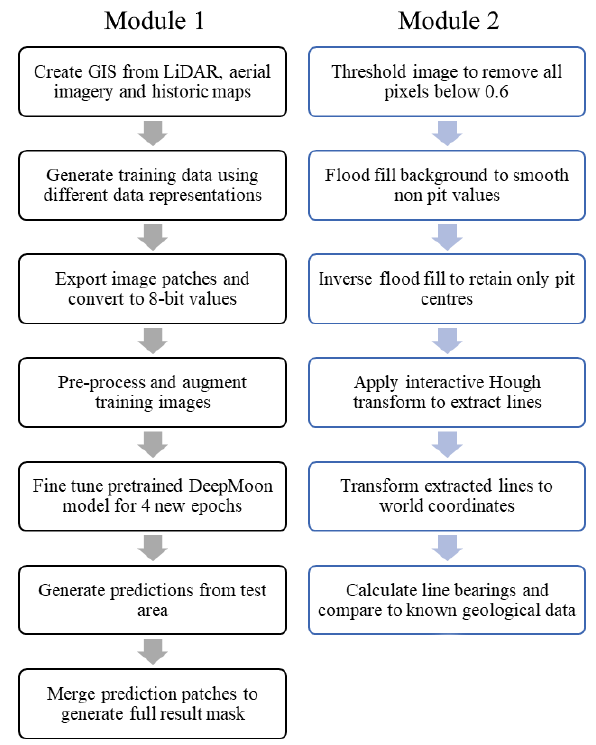
Figure 3. Processing workflow diagram showing both the deep learning pit detection module and the line fitting module